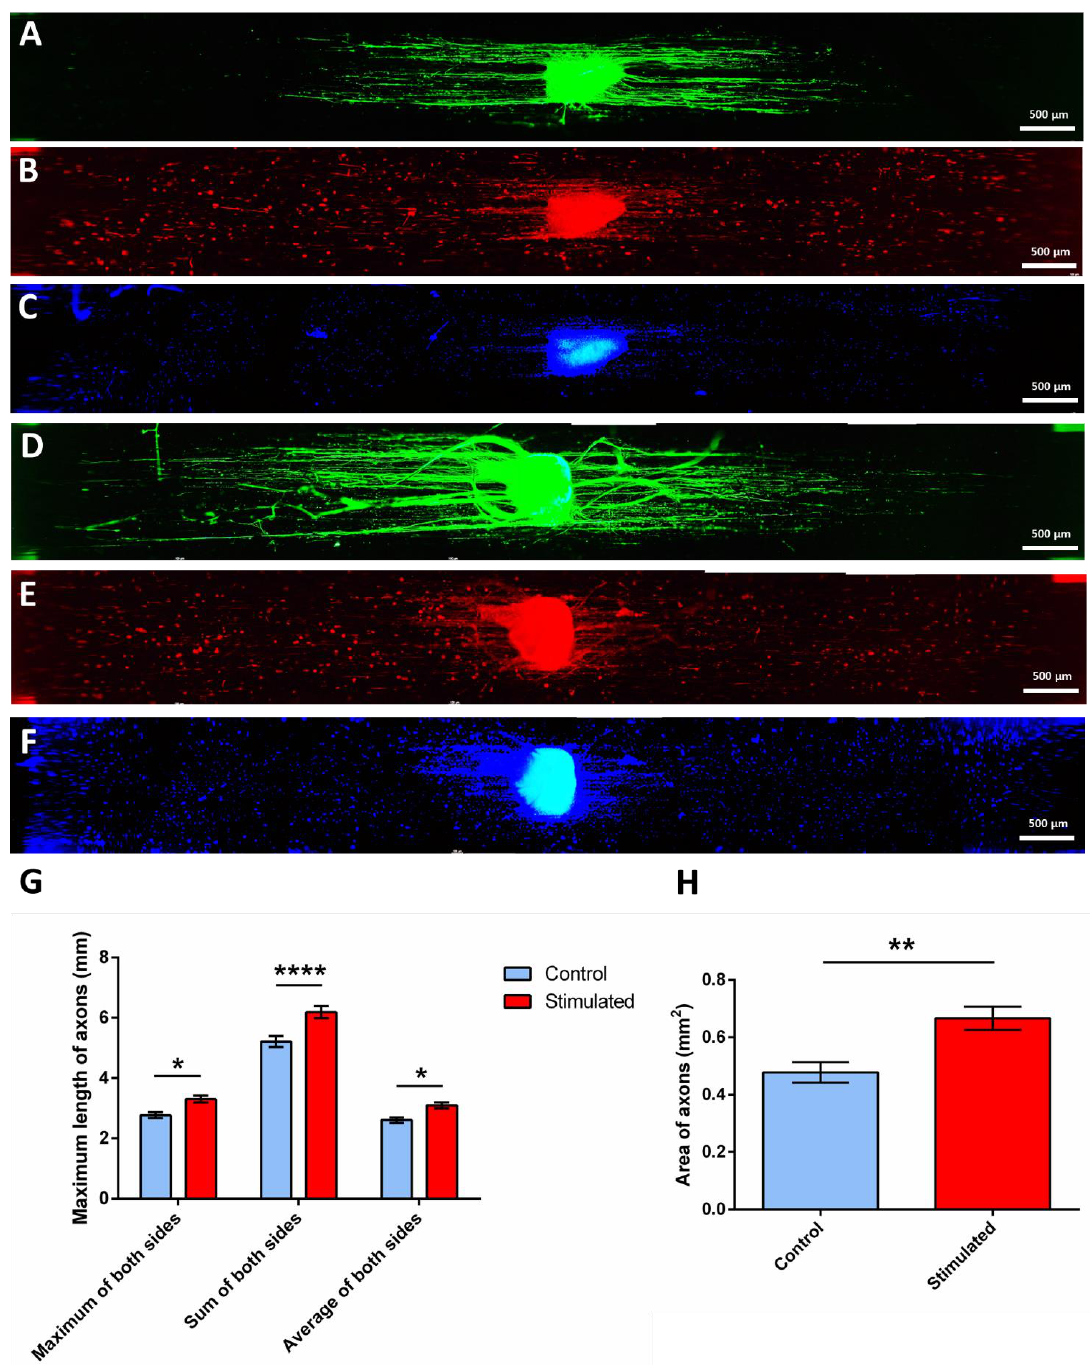
Figure 6. Example of control ( A – C ) and electrically stimulated ( D – F ) samples. Axons marked with β III Tubulin are shown in green colour ( A , D ), Schwann cells marked with S100β are shown in red colour ( B , E ) and the cell nuclei marked with DAPI are shown in blue colour ( C , F ). It can be observed the increase in the length and in the total area occupied by axons for the electrically stimulated